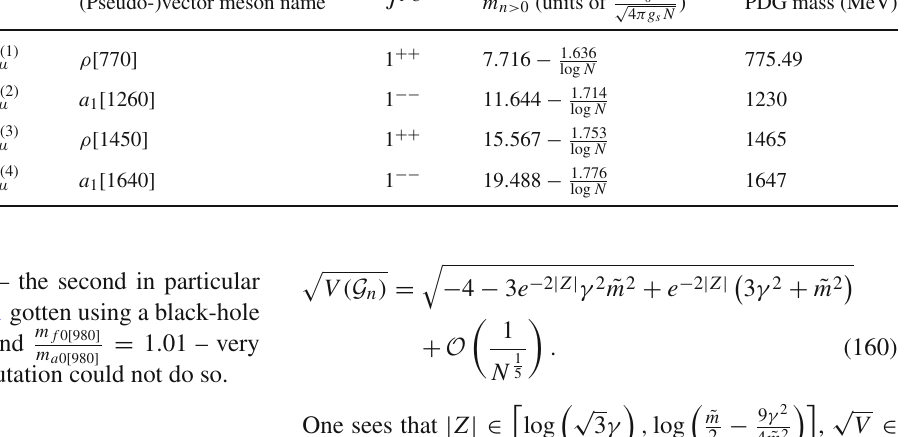
Table 5 (Pseudo-)vector meson masses from WKB